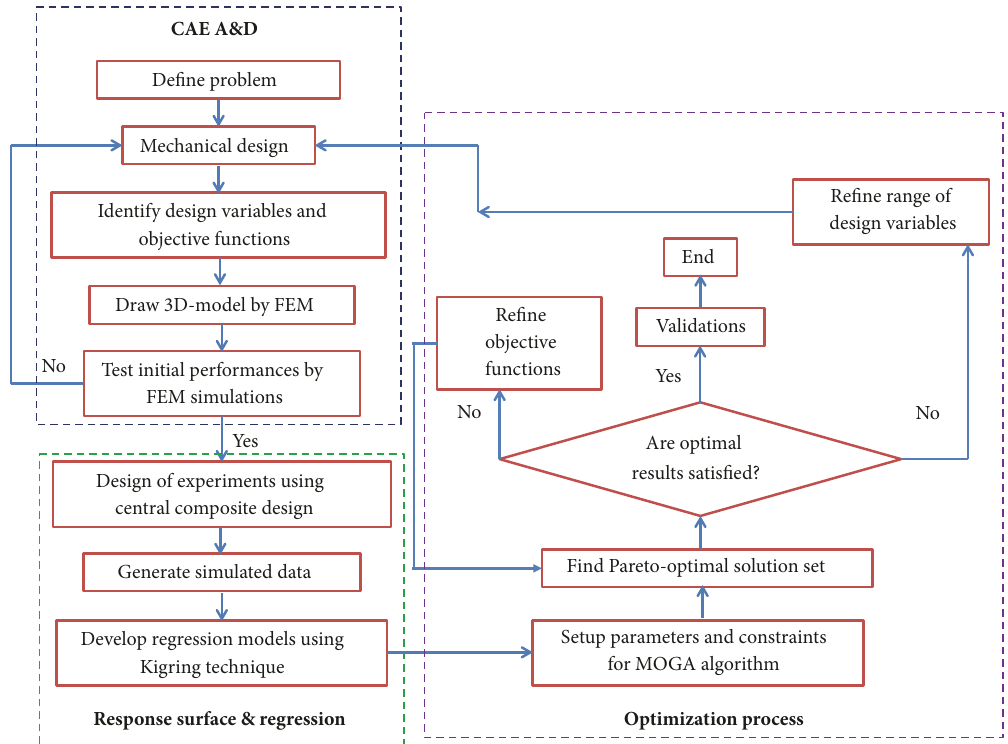
Figure 7: The flowchart of multiobjective optimization